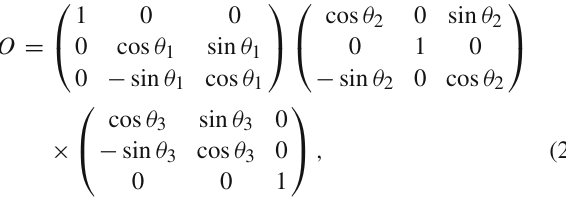
Fig. 6 The luminosity required to obtain 25 signal events of the Z (cid:2) bosonasafunctionof x H forfixedvaluesof m Z (cid:2) = 3TeVand m N 1 , 2 , 3 = m Z (cid:2) / 4. The dotted (dot-dashed) lines correspond to the NH (IH)